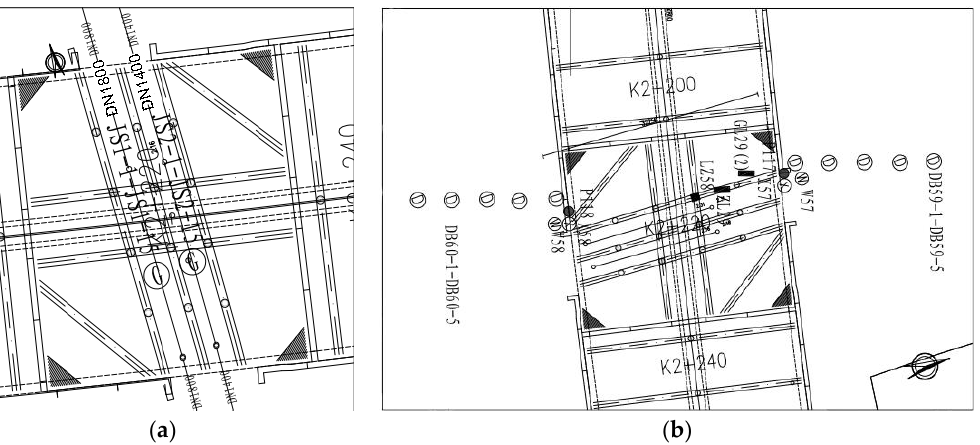
Figure 7. Plan view showing arrangement of the monitored items: ( a ) Pipeline displacements; ( b ) Ground surface settlements, displacements at diaphragm wall top, lattice column displacements, groundwater level, and axial forces in concrete and steel struts. Table 4. Summary of the monitoring devices used in this deep-braced excavation and their ver- sions.